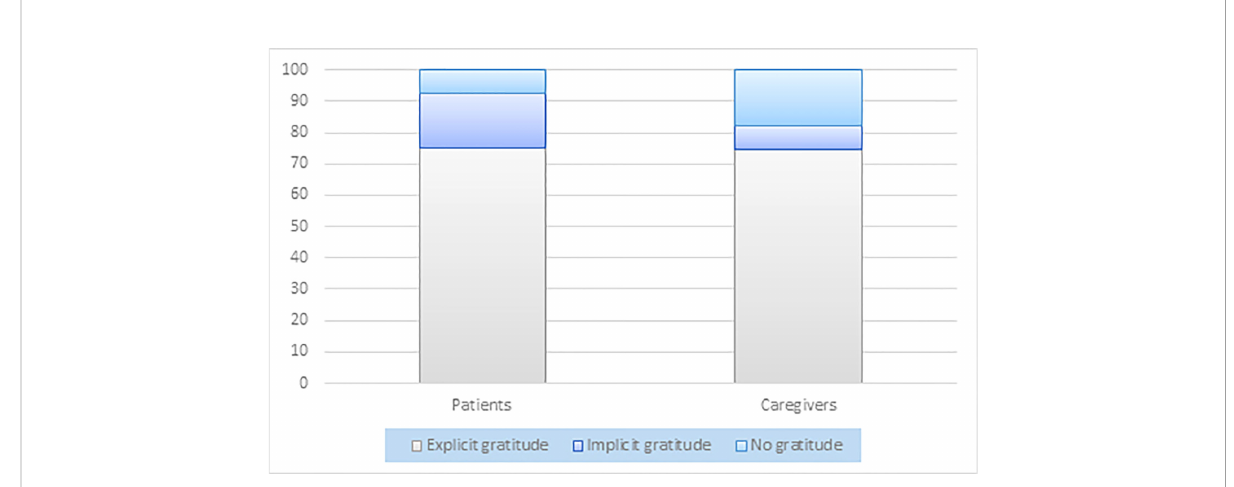
FIGURE 1 Graphical representation of the percentage proportion between reports showing explicit, implicit, and no gratitude for patients and